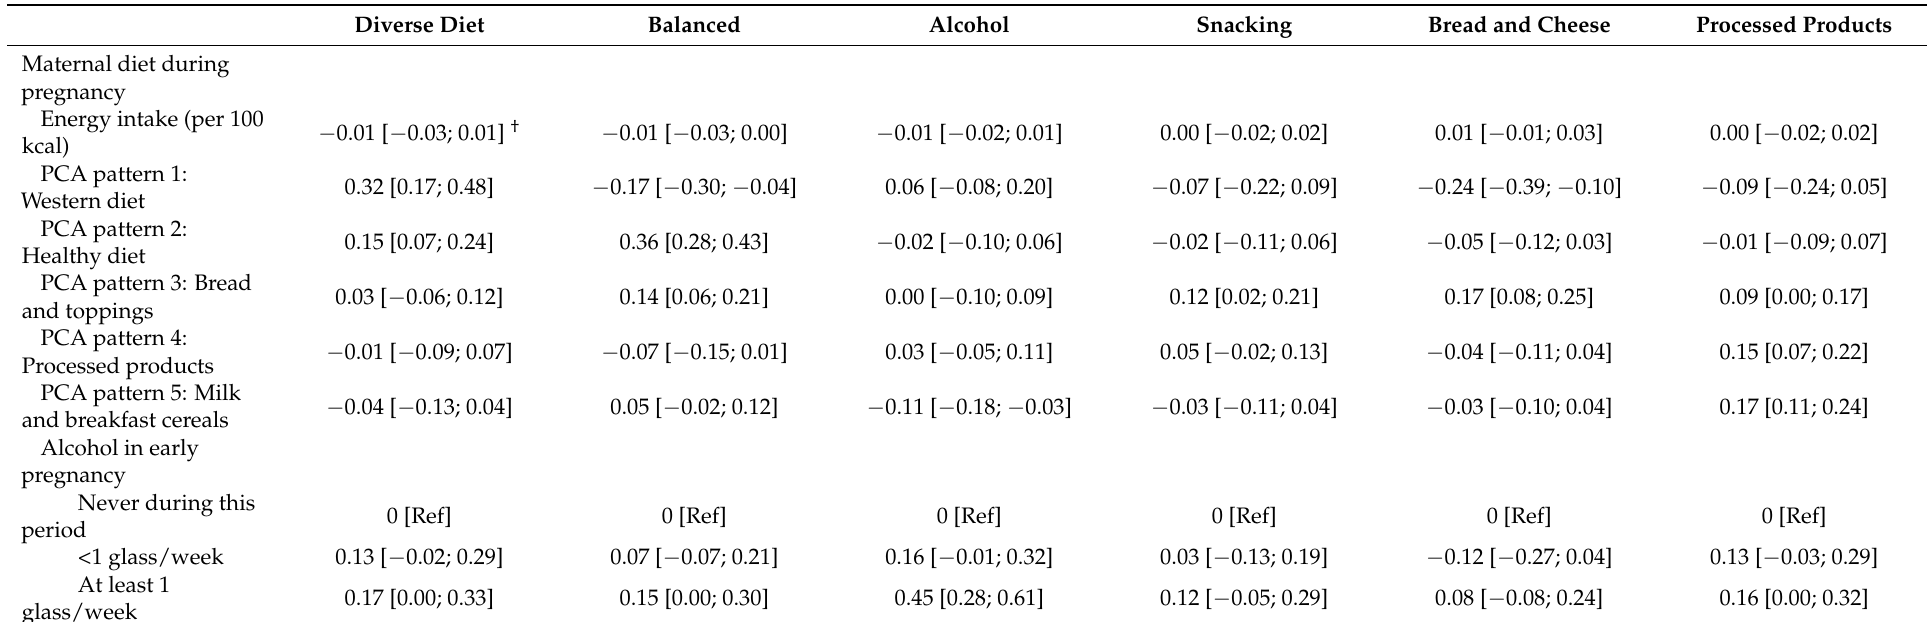
Table 5. Multivariable associations between maternal diet and paternal diet ( n = 998): the ELFE study, 2011. Diverse Diet Balanced Alcohol Snacking Bread and Cheese Processed